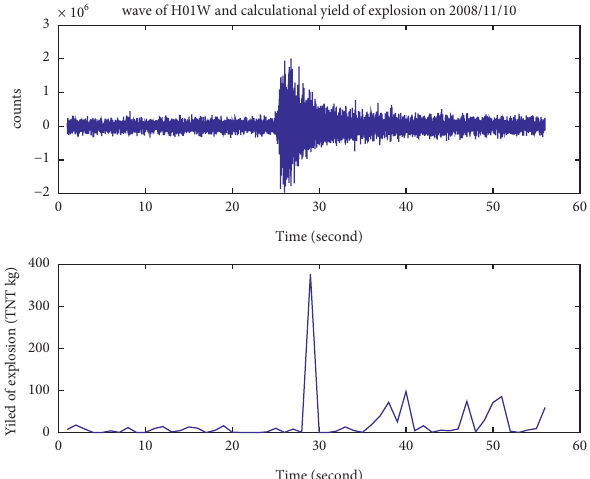
Figure 5: Equivalent estimation monitoring threshold trace in 90% probability of the H01W